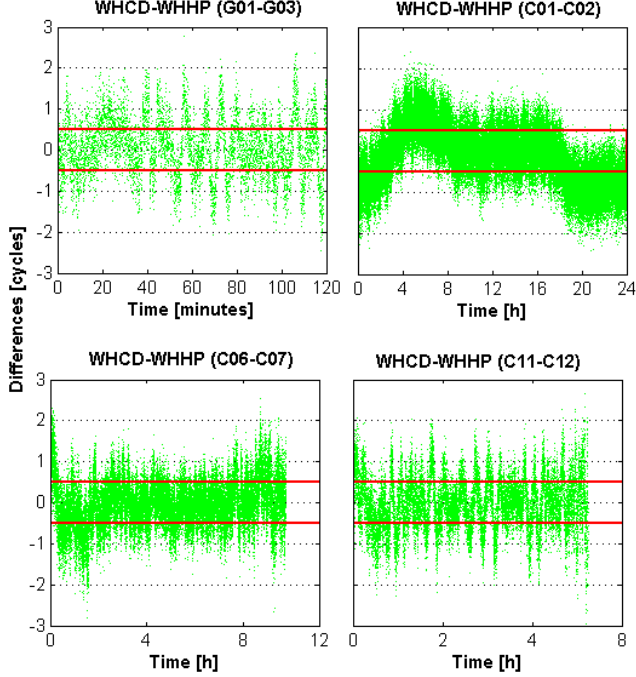
Figure 2. Dual-frequency WL float ambiguities of the GPS and BDS satellites for baseline WHCD-WHHP. The red line indicates the threshold for rounding. Green dots indicate the values of WL float ambiguities.